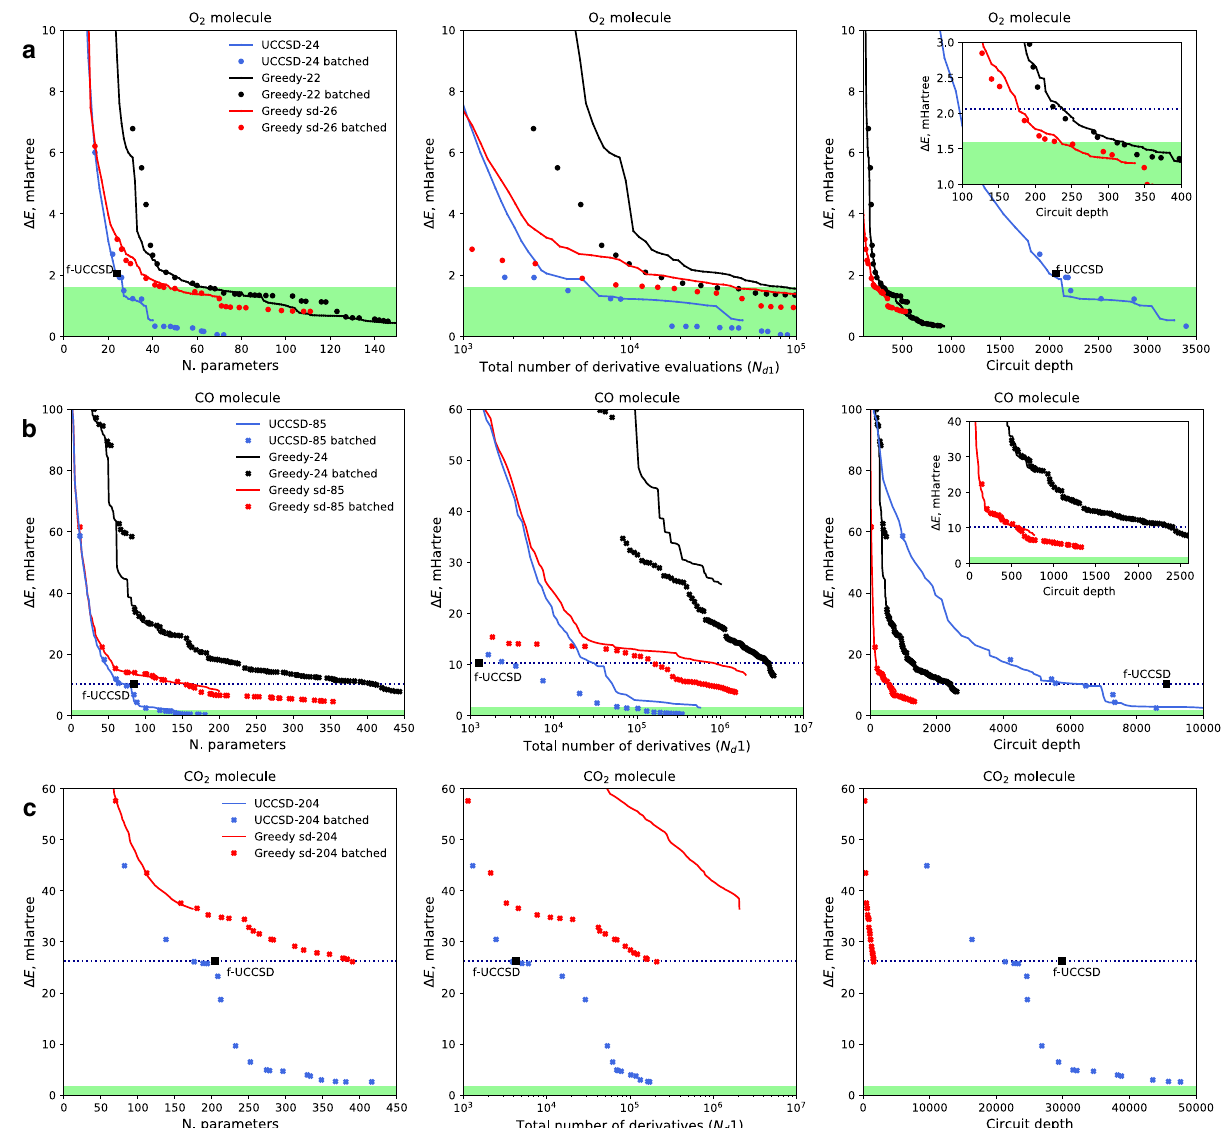
Fig. 6 ADAPT-VQE and VQE-UCCSD convergence of the energy with respect to the number of parameters, the total number of derivatives and the circuit depth for O 2 , CO and CO 2 molecules. Fermionic ADAPT-VQE results are marked as "UCCSD- N '', where N indicates the size of the fermionic pool with single and double excitations. Qubit ADAPT-VQE results are referred to as Greedy- N (qubit linear complete pool) and Greedy sd- N (qubit polynomial complete pool with Pauli strings originated from each single and double fermionic excitation), where N is the qubit pool size. "f-UCCSD" refers to VQE- UCCSD result. By the green color we highlight the area, where the chemical accuracy threshold is satis fi es. a Energy convergence for O 2 molecule at the equilibrium geometry. As far as single qubit operator, which is obtained from each fermionic excitations do not form a complete pool, we add two extra operators to ensure pool completeness. Thus greedy sd pool contains 26 operators in this case. b Energy convergence for CO molecule at the equilibrium geometry. c Energy convergence for CO 2 molecule at the equilibrium